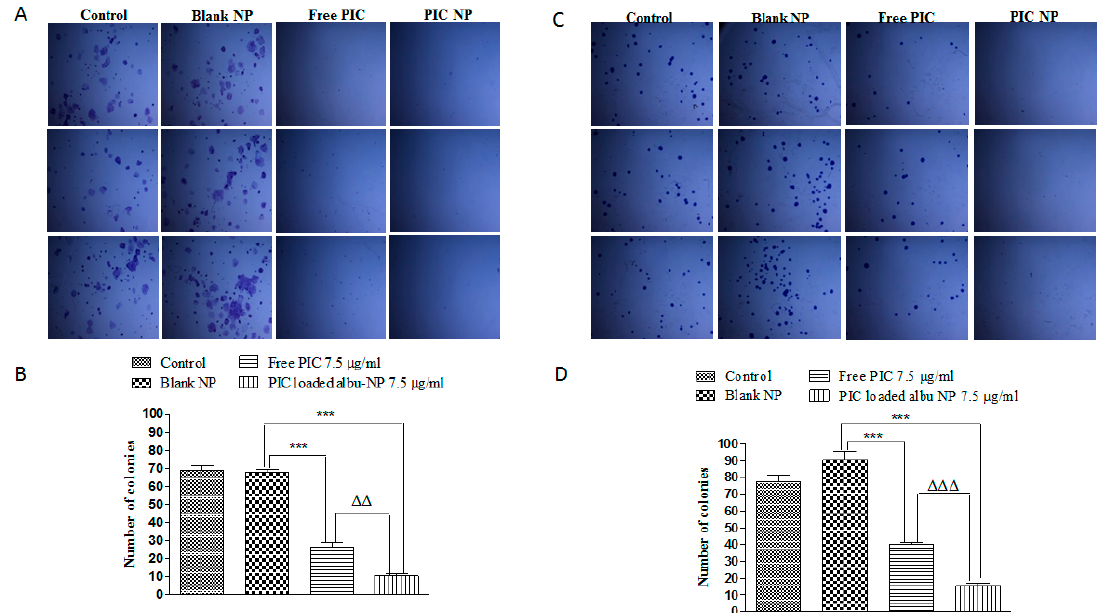
Figure 3. E ff ect of PIC-loaded albumin nanoparticles on colony formation e ff ect of PIC-loaded albumin NPs and free PIC on colony formation ability of CaCo-2 cell lines. The above images in ( A ) show a pattern of colon formation in control, blank NPs, free PIC, and PIC-loaded albumin NPs treated the group as demonstrated in the microscopic images. ( B ) represents significant ( p < 0.01) variation in colony formation upon treatment with free PIC and PIC-loaded albumin NPs. The PIC-loaded albumin NPs show a significantly lower number of colonies than free PIC. Values are mean ± SEM with n = 3. *** p < 0.001 compared with blank NPs. ∆∆ p < 0.01 compared with the same dose of free PIC. Similarly, ( C , D ) represents the e ff ect of PIC-loaded albumin NPs and free PIC on colony formation ability of HT-29 cell lines. ( C ) shows a pattern of colony formation in control, blank NPs, free PIC, and PIC-loaded albumin NPs treated the group as demonstrated in the microscopic images. ( D ) represents ( p < 0.001) variation in colony formation upon treatment with free PIC and PIC-loaded albumin NPs. The above figures reveal that PIC-loaded albumin NPs show a significantly lower number of colonies than free PIC. Values are mean ± SEM with n = 3. *** p < 0.001 compared with blank NPs. ∆∆∆ p < 0.001 compared with the same dose of free PIC.